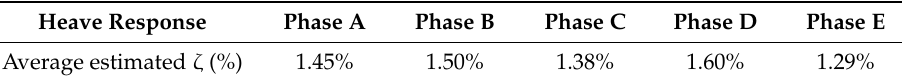
Figure 11. Heave response of platform to decay test for different phases. Table 5. Heave damping ratio estimates.